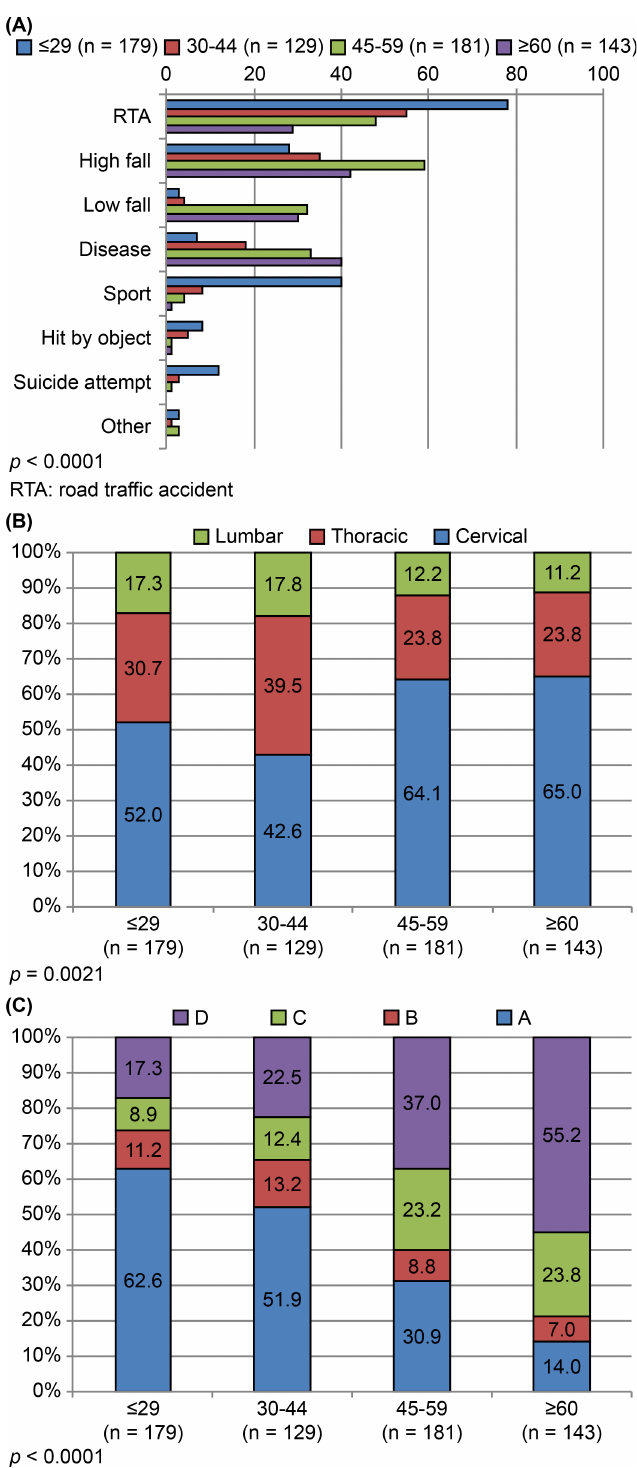
Fig 5. (A) Age-group distributions for various causes of spinal injury. (B) Distributions of spinal injury levels within patient age groups. (C) Distributions of AIS scores within patient age groups.